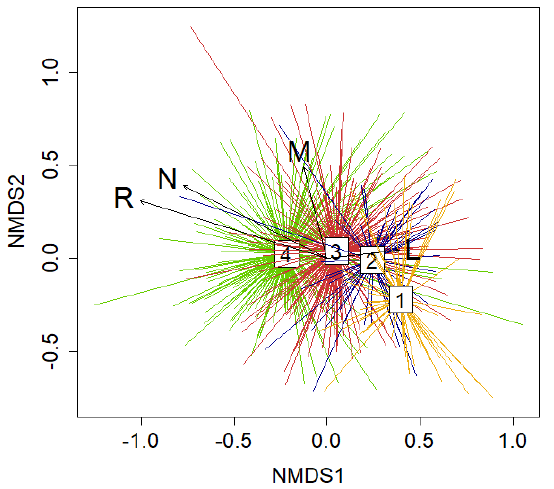
Figure 8. NMDS ordination of community groups of spruce and spruce–aspen / birch formations